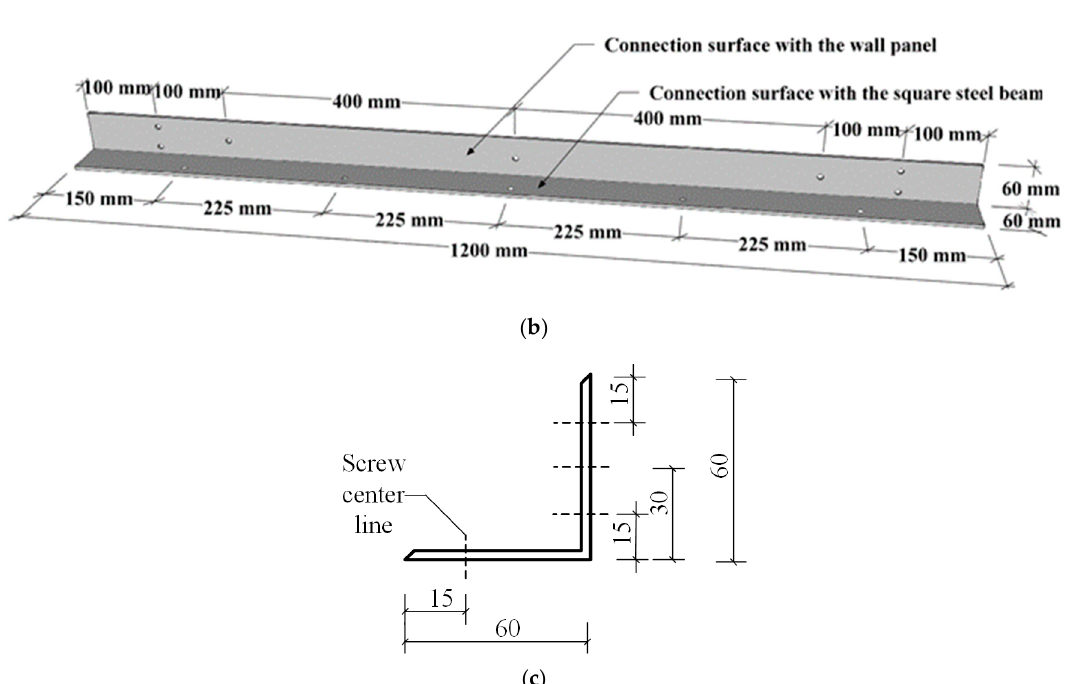
Figure 2. Dimension of L-shaped connector and hole positions (mm). ( a ) Hole positions of L- shaped connector connected with steel beam by three self-drilling screws. ( b ) Hole positions of L- shaped connector connected with steel beam by five self-drilling screws. ( c ) Section dimension of L-shaped connector.